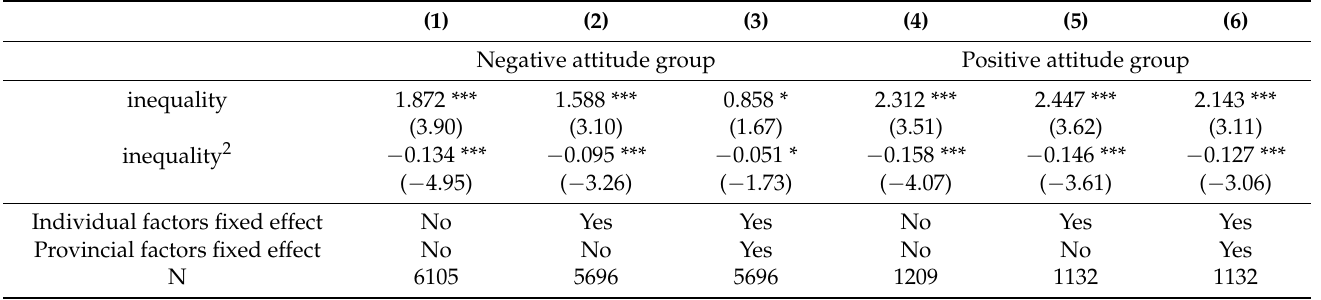
Table 13. The effect of individual-level income inequality on subjective environmental pollution: differences in environmen- tal